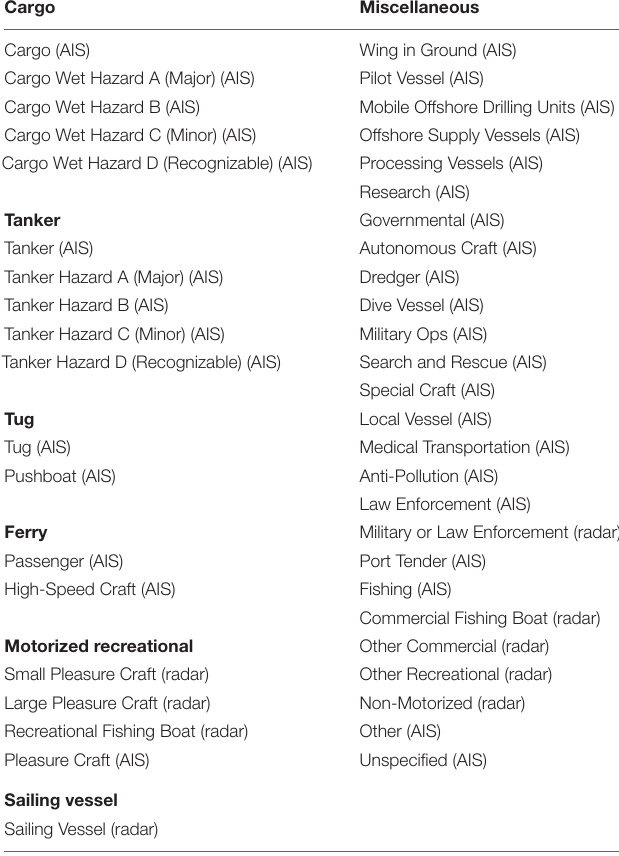
TABLE 1 | Vessel types and vessel type